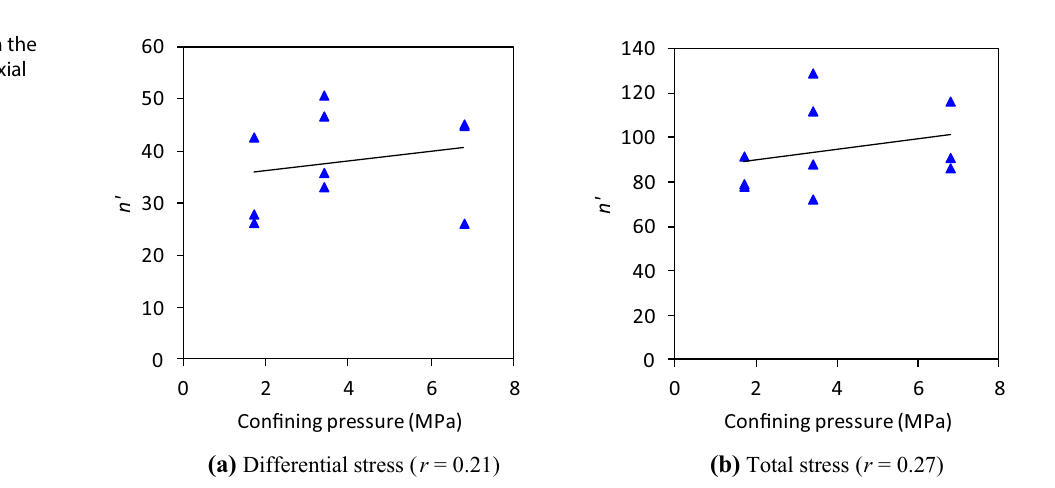
Fig. 15 The n’ -values from the alternating strain rate triaxial